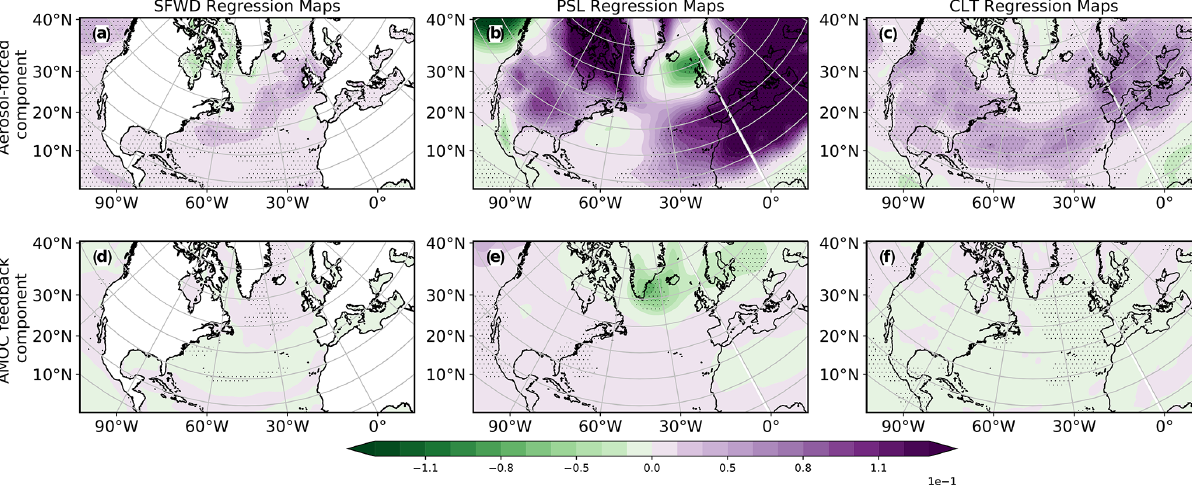
Figure 6. The 1940–2020 ensemble mean annual mean CMIP6 all forcing regression analysis: decomposition of (a, d) surface wind speed (SFWD), (b, e) sea level pressure (PSL), and (c, f) total cloud cover (CLT) into (top panels) aerosol-forced and (bottom panels) AMOC feedback components. The forced response is obtained by regressing the subpolar North Atlantic − 1 · SW time series (a proxy for an- thropogenic aerosols) onto each field. The AMOC-related feedback is obtained by removing the variability associated with the forced response, and then regressing the AMOC time series onto this new field. The feedback field is converted to the same units as the aerosol- forced field by multiplying the feedback field by the regression slope between the AMOC and − 1 · SW subpolar North Atlantic time se- = 0 . 32Sv ( Wm − 2 ) − 1 , significant at the 95% confidence level. The units for SFWD, PSL, and CLT regression maps ries δ( AMOC ) δ( − 1 · SW )